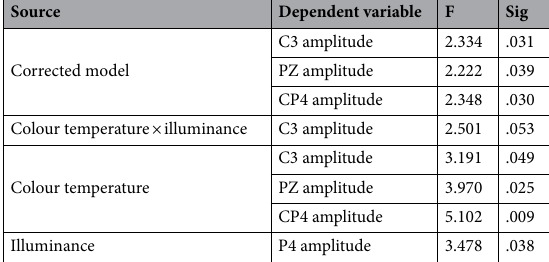
Table 2. Significance analysis of the influence of colour temperature and illuminance on P3b amplitude.